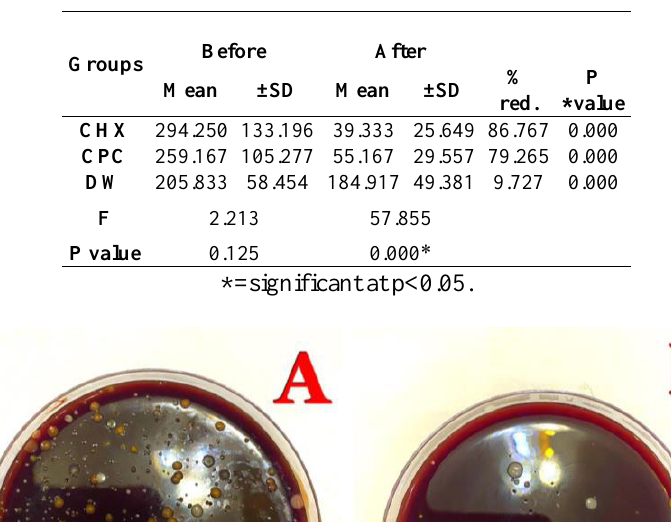
Figure 2: The mean of bacterial colony before and after treatment among groups at three positions. Table 3: Bacterial colony mean and percentage of reduction among groups before and after rinsing at patient chest position.